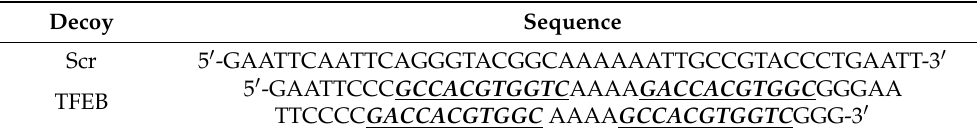
Figure 6. Synthesis of TFEB decoy oligodeoxynucleotide (ODN). The design of ring-type TFEB decoy ODNs including GCCACGTGGTC (underlined), which is the consensus sequence for the TFEB-binding element. Table 1. Sequences of the ODNs used in this study. The target site of the synthesized TFEB decoy ODN sequence is